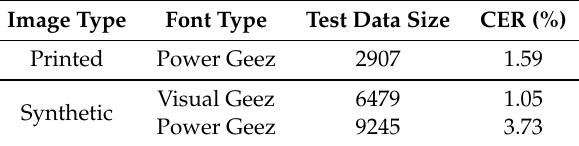
Table 4. Experimental results (Character Error Rate (CER)).